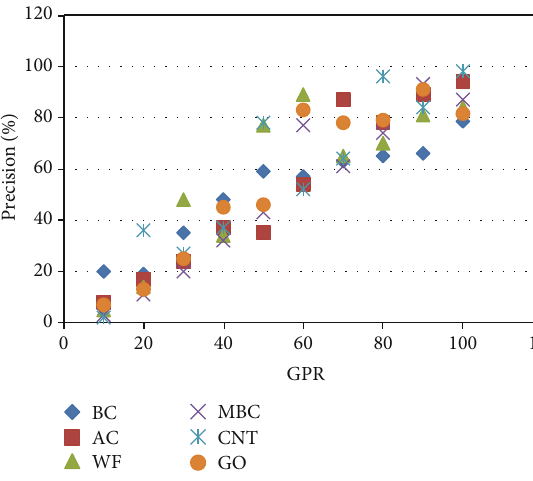
Figure 2: Accuracy of CBMs.